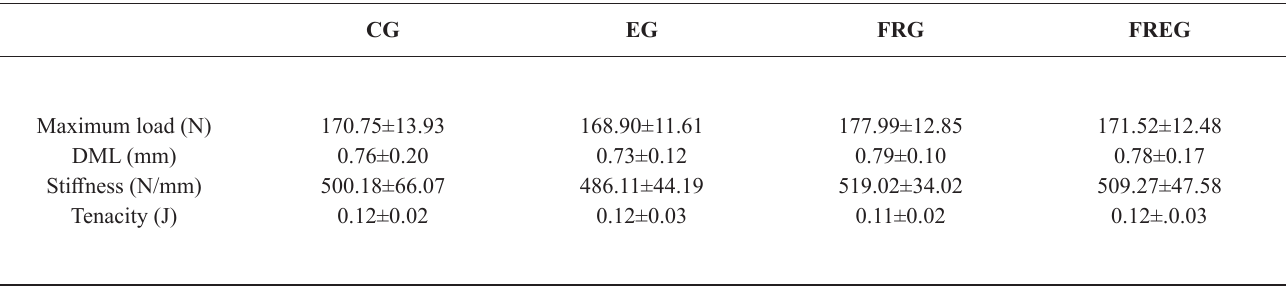
Table 2 - Biomechanical outcomes of the femur in control (CG), exercised (EG), food restriction (FRG), and food restriction/exercised (FREG) from female